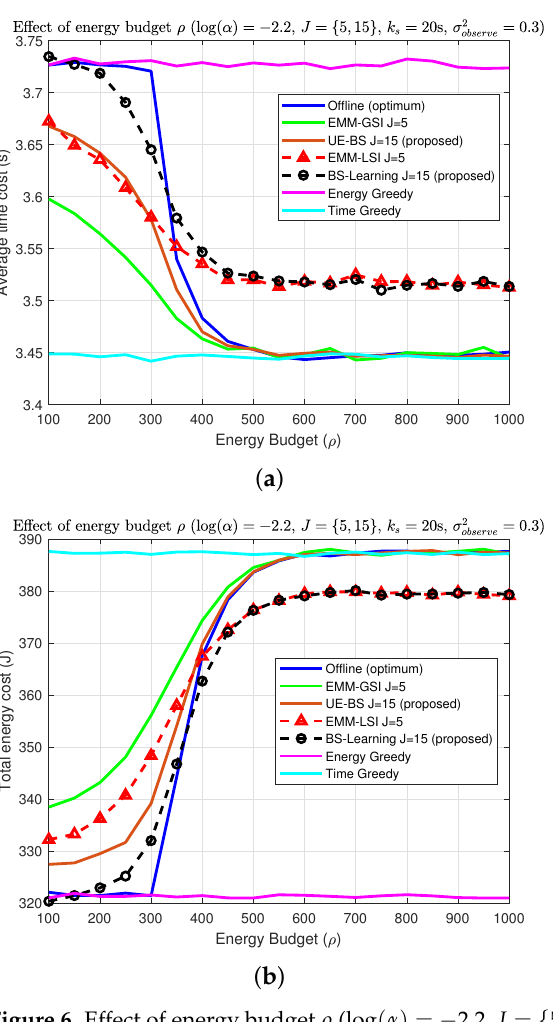
Figure 6. Effect of energy budget ρ (log ( α ) = − 2.2, J = { 5,15 } , k s = 20 s, σ 2 time cost; ( b ) total energy